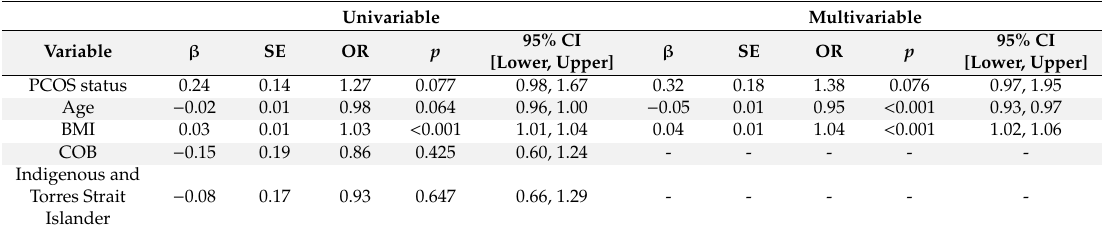
Table 4. Factors associated with eating disorders in women with and without